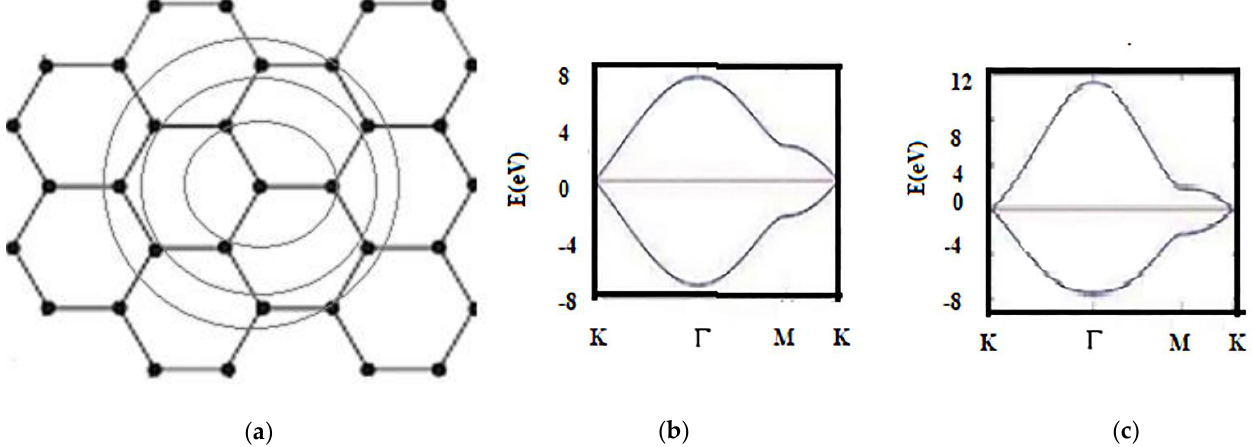
Figure A4. Energy dispersion for 2 s , 2 px , 2 py , and 2 pz . ( a ) Different orbits of graphene; ( b ) valence and conductance band; ( c ) energy dispersion of different orbits of graphene. Additionally, for the three nearest neighbors, the dispersion energy is shown in Figure A5.